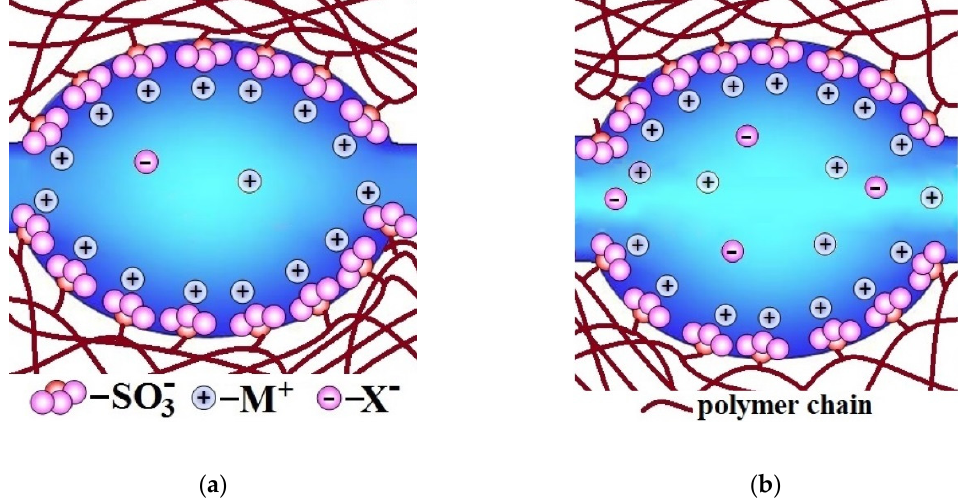
Figure 2. Illustration of the change in pore-channel system of membranes with increasing water uptake (from ( a ) to ( b ).